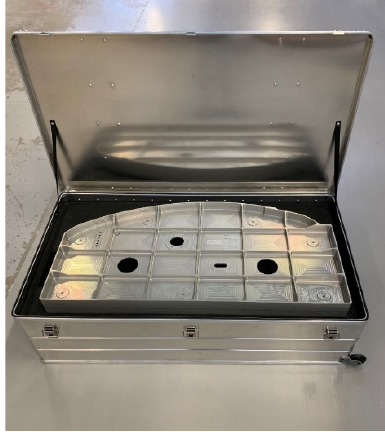
Figure 14. Each MPQP test artefact is securely stored in dedicated and marked aluminium contain- ers/boxes. Every container/box can store a maximum of two MPQP